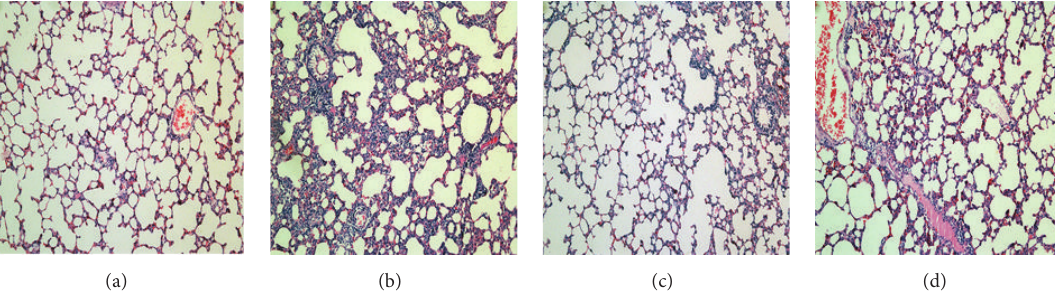
Figure 2: Histopathological changes in the lung of rats. On the seventh day of infection with biofilm-covered tube intubation: control group